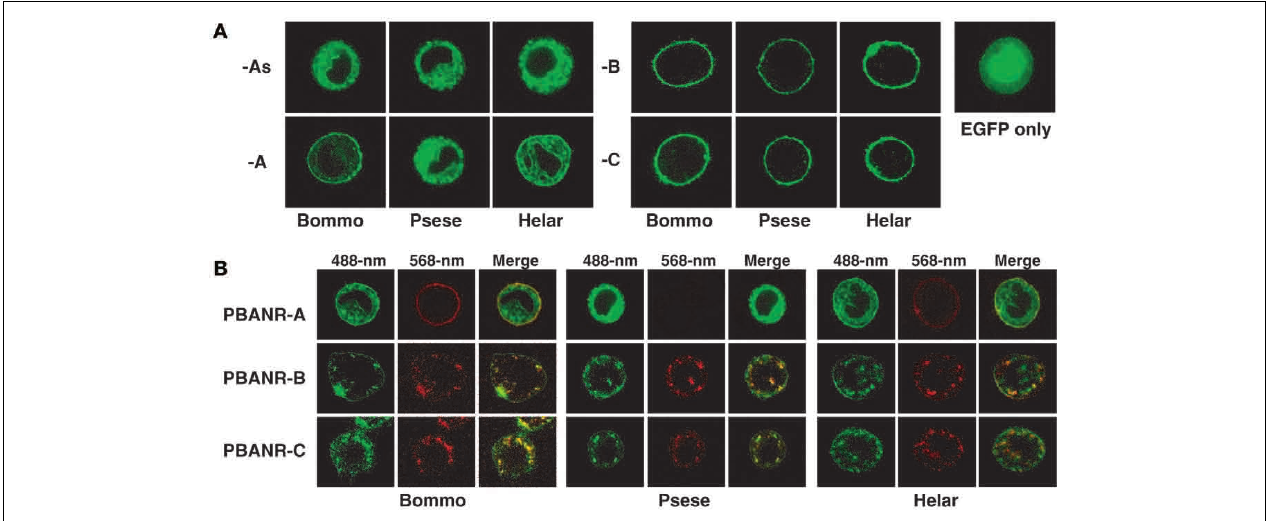
FIGURE 11 | Confocal imaging of fluorescent chimeras of the PBANR variants transiently expressed in Sf9 cells. (A) Localization of EGFP-tagged PBANR variants. For control purposes, Sf9 cells were transfected with an